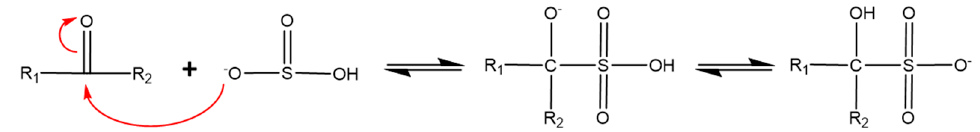
Figure 3. Hydroalkylsulfonate adduct formation equilibrium.